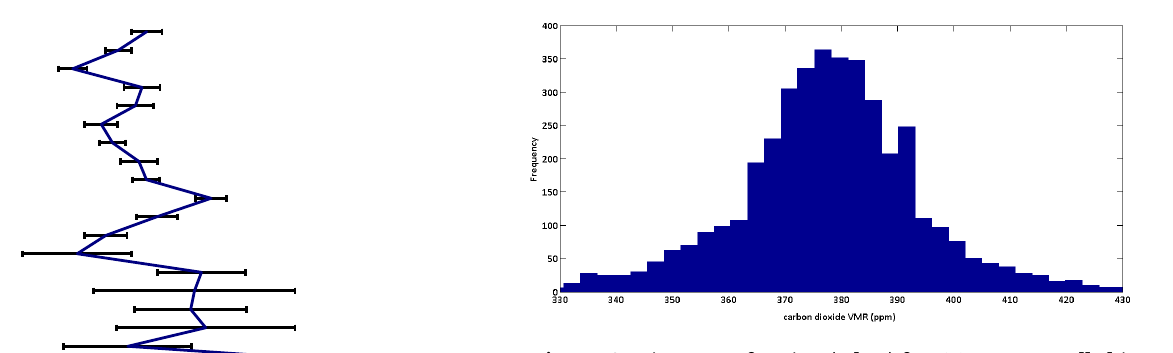
Figure 10. Histogram of retrieved cloud-free CO 2 VMR at all alti- tudes (5–25km), globally, in the 2009–2011 time frame. Outside of this range, the frequency distribution tends to be random (no resem- blance to a